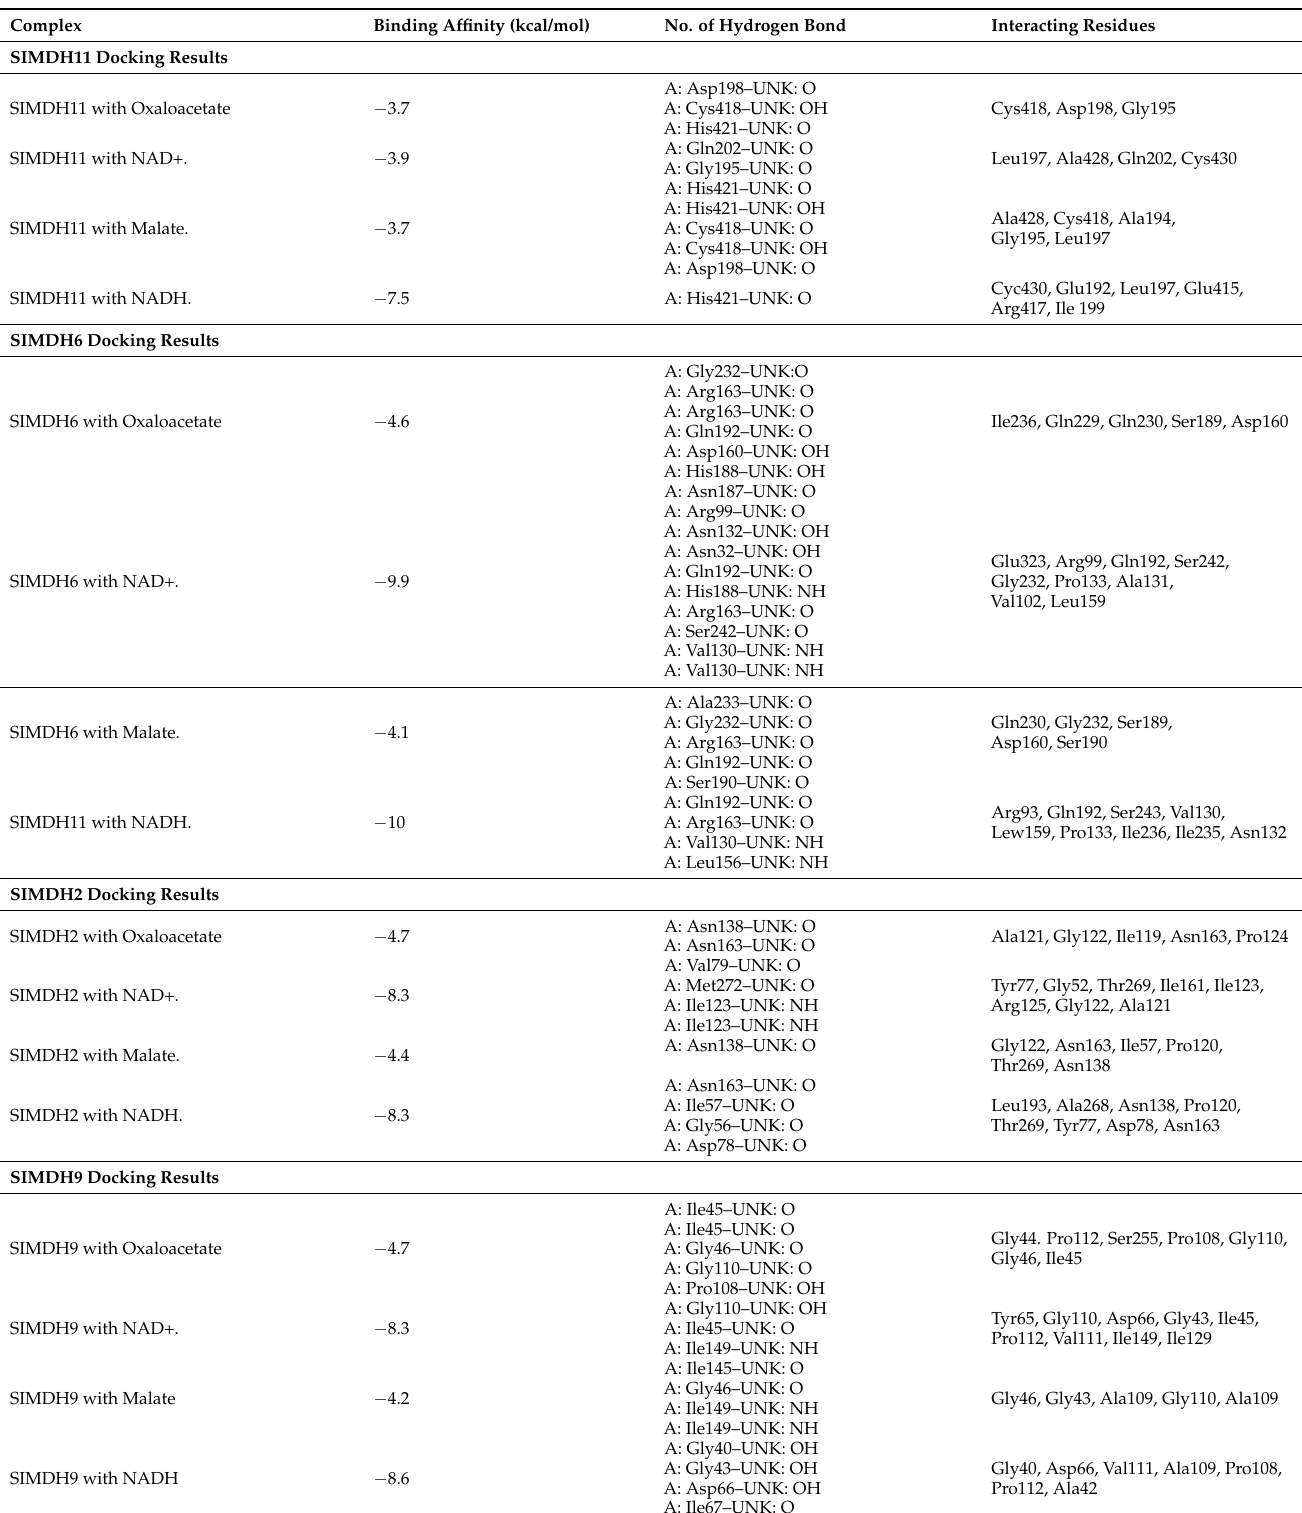
Table 2. Molecular docking results of the selected tomato proteins with different substrates (malate and oxaloacetate) and cofactors (NAD+ and